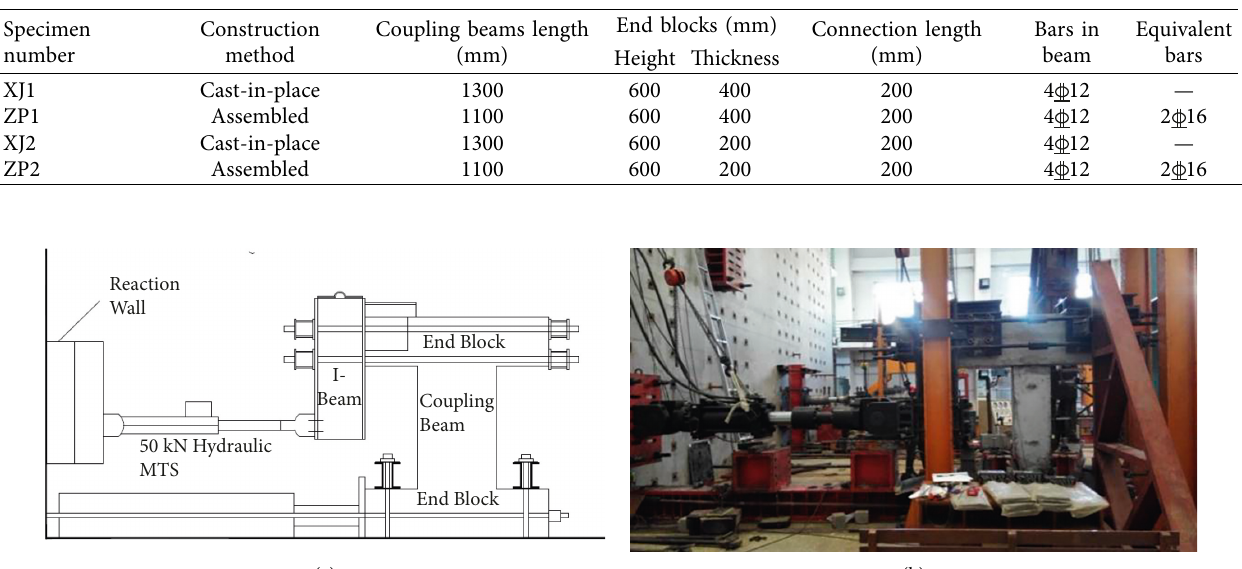
Figure 2: Reinforcement and geometric size drawing of all the specimens. (a) Diagram of XJ1. (b) Diagram of ZP1. (c) Diagram of XJ2. (d) Diagram of ZP2. Table 1: Overview of test pieces.